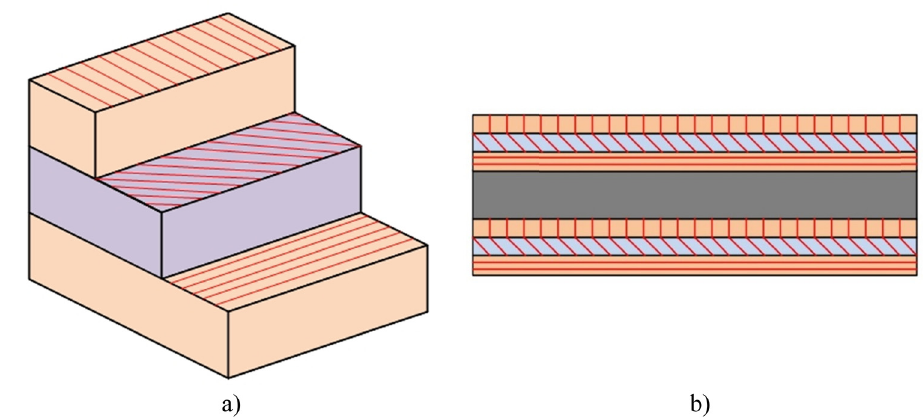
Figure 7: Diagram of pavement: ( a ) step view and ( b ) stacked